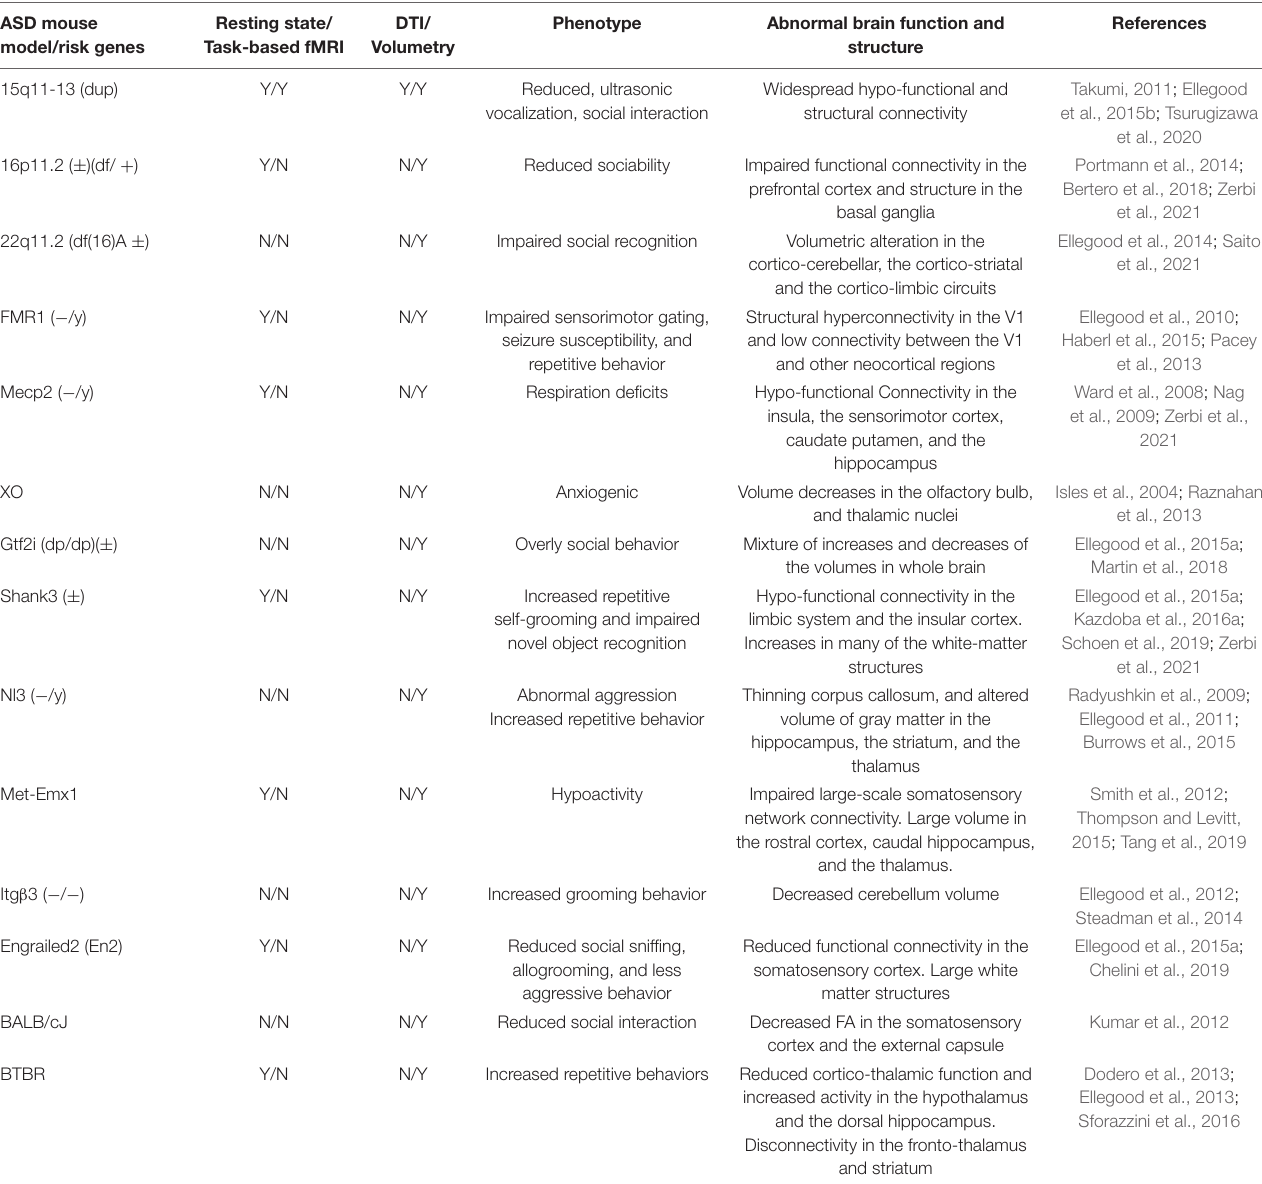
TABLE 1 | ASD mouse models and MRI